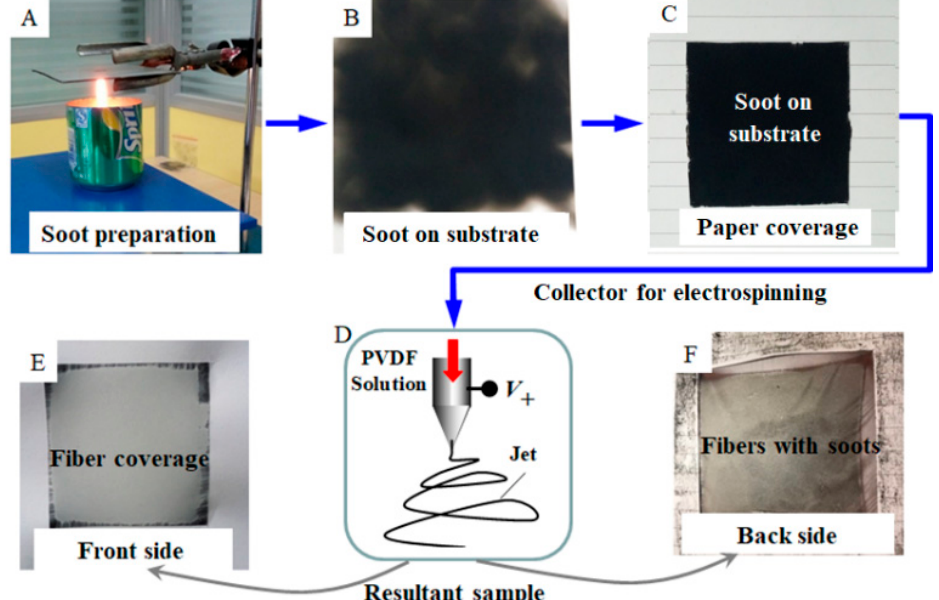
Figure 1. Process for the preparation of candle soot and superhydrophobic poly(vinylidene fluoride) (PVDF) membranes: ( A ) an image presenting the collection of candle soot via holding sheet metal on the flame, ( B ) a photo of sheet metal covered with the candle soot, ( C ) a piece of paper (with a square-shape opening) sticking to the sheet metal, and ( D ) the schematic electrospinning process taking the paper and metal as the substrate, on which there is the deposited fibrous membrane. The soot is pasted on the back side ( F ) of the membrane rather than the front side ( E ). A vertical setup was utilized for the electrospinning (Figure 1D), the procedure